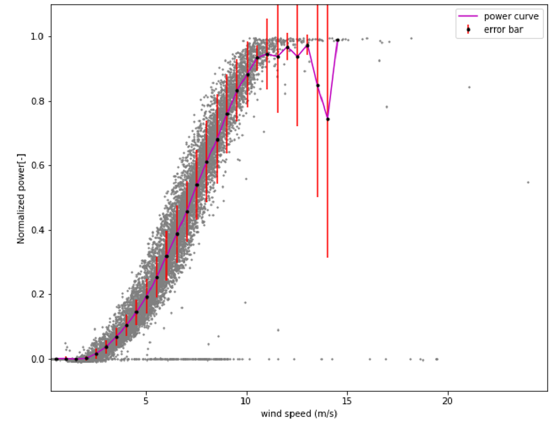
Figure 10. Power curve based on database before cleaning.